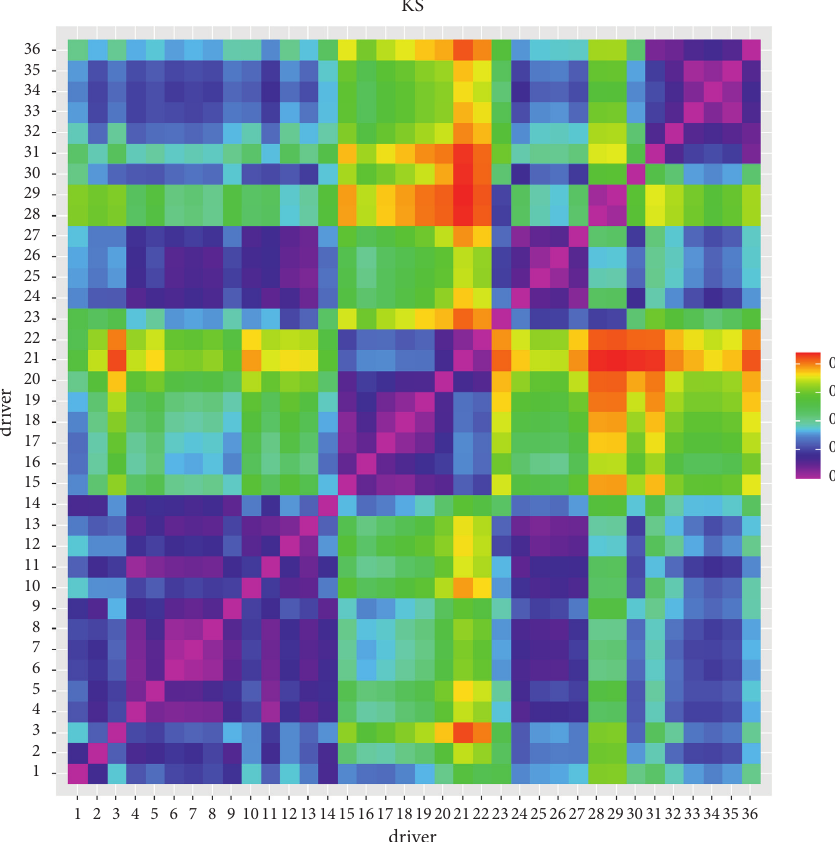
Figure 3: KS test between two normalized distributions of driving patterns among all